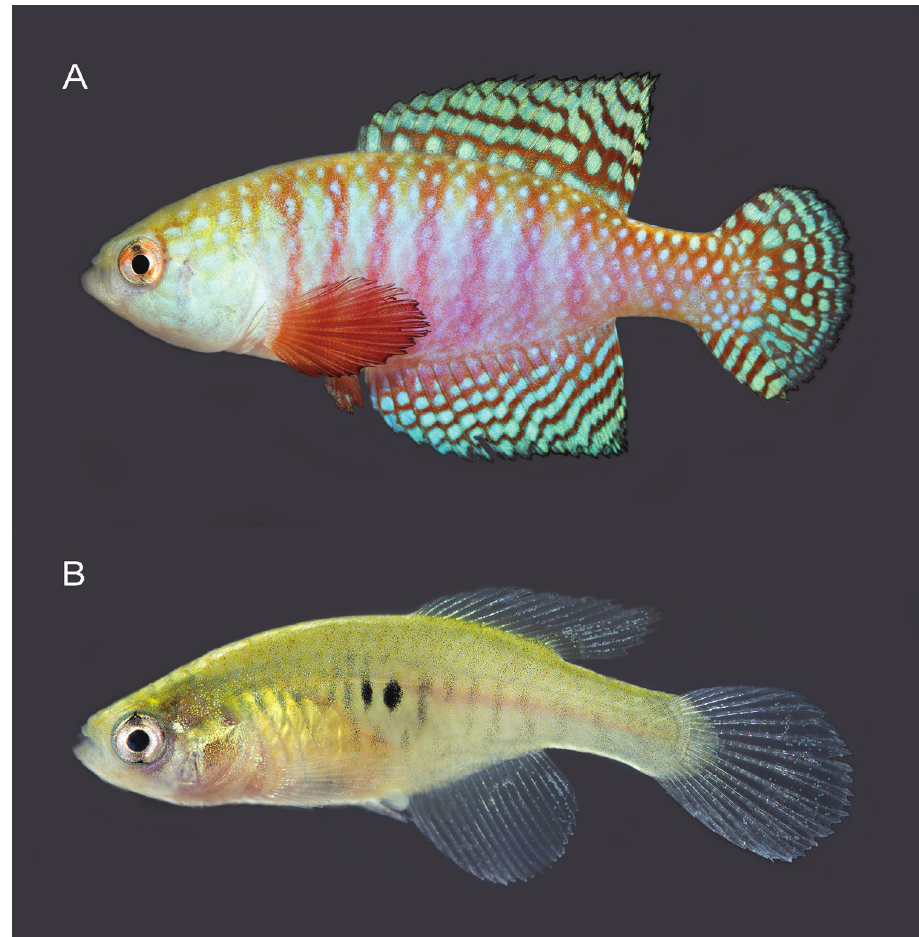
Figure 4. Hypsolebias hamadryades sp. n. A live holotype, UFRJ 6893, male, 26.9 mm SL (caudal fin dam- aged and regenerated) B live paratype, UFRJ 6895, female, 21.2 mm SL. Photographs by WJEM fins in males wider than interspace (vs. transverse series of dots or stripes narrower than interspace). It also differs from all other species of the complex by the following combi- nation of character states relative to the male colour pattern: dorsal fin with transverse blue stripes and one basal row of blue dots (vs. rows of blue dots on the whole fin in H. picturatus ); anal fin with transverse blue stripes on most portion of the fin (vs. dots and short vermiculate marks arranged on most part of the fin in H. gardneri , H. harmonicus and H. picturatus ); and most portion of caudal fin with blue bars (vs. anterior half of caudal fin with transverse rows of blue dots, posterior half with transverse blue bars in H. gardneri and H. harmonicus , or dots on the entire fin in H. picturatus ), and the presence of eight to ten light red bars between humeral region and the anterior part of the caudal peduncle (vs. six or seven in H. magnificus , H. harmonicus and H. gardneri ).